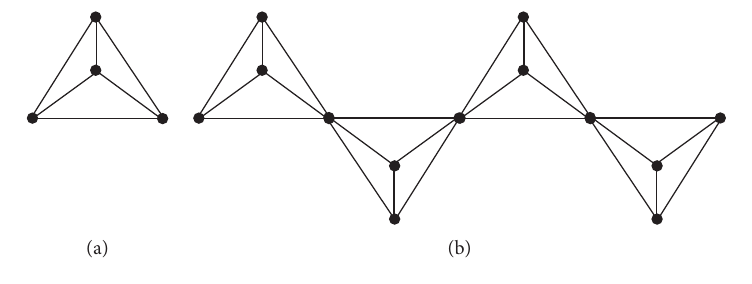
Figure 2: (a) Single silicate and (b) chain silicate. Table 7: Edge partition of chain silicate network of n order.